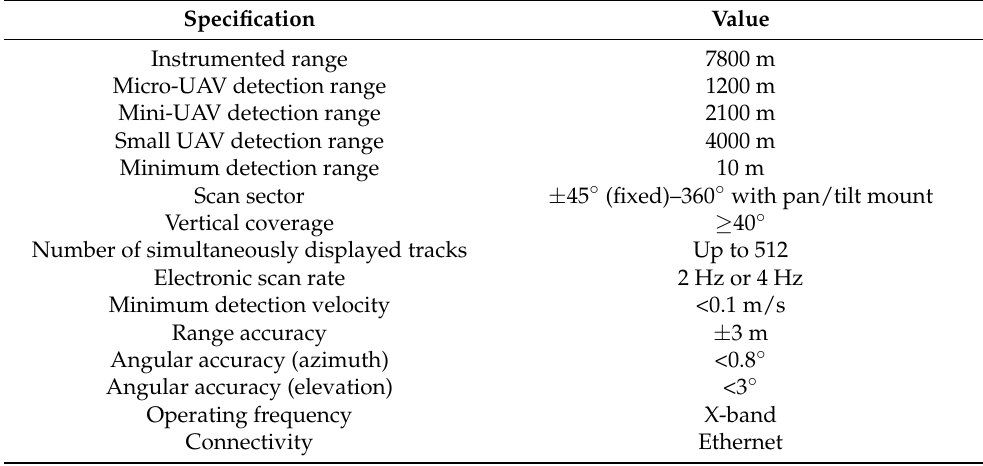
Table 5. Ranger R8SS-3D